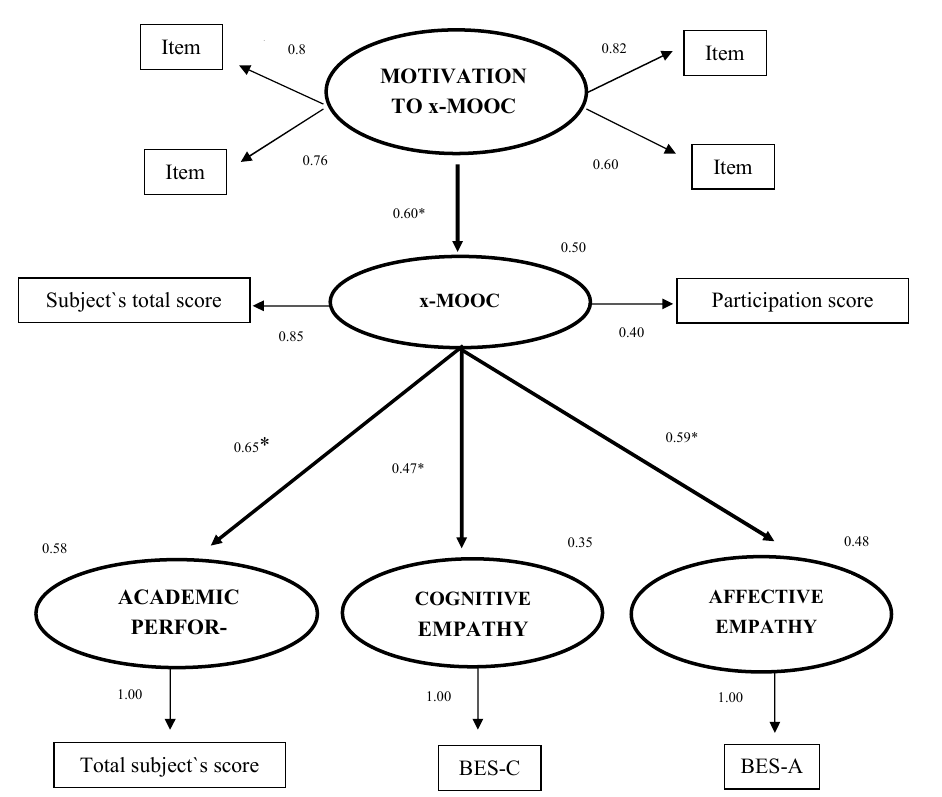
Figure 1. Empirical model. Observed variables (Factors/Scales) are represented by squares and latent variables by circles. Abbreviations: BES-C = Cognitive sub-scale of the Basic Empathy Scale; BES-A = Affective sub-scale of the Basic Empathy Scale * p ≤